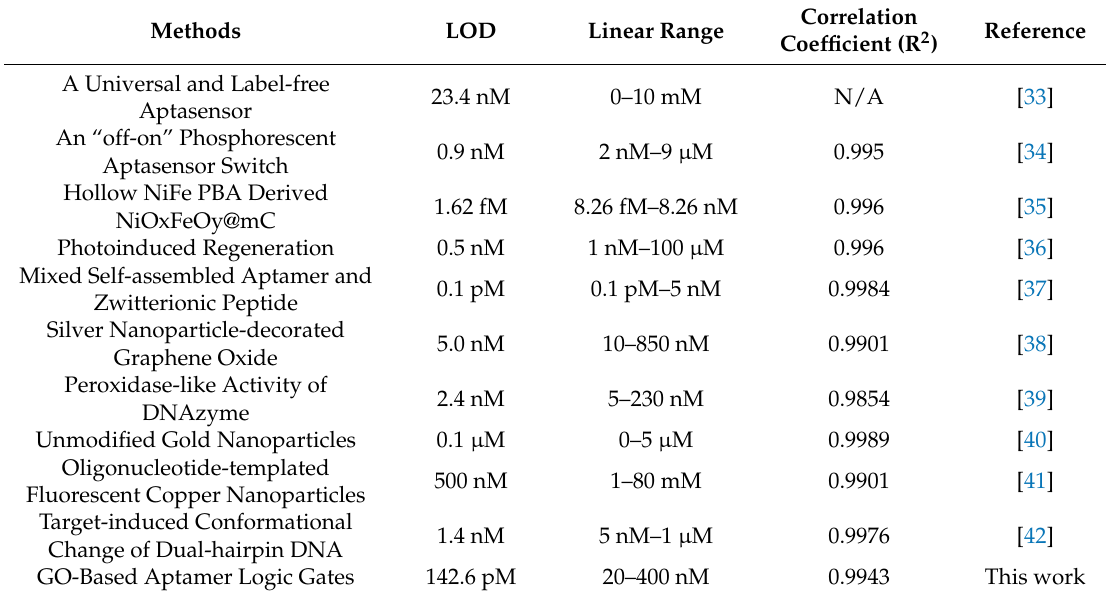
Figure 5. ( A ) Spectral detection at different ATP concentrations; ( B ) the linearity of the sensor; ( C ) the sensor sensitivity. DNA-T, DNA-M, DNA-M’, GO, and ATP (0 nM, 20 nM, 50 nM, 100 nM, 200 nM, 300 nM, 400 nM). Table 3. Comparison of other methods for ATP detection.